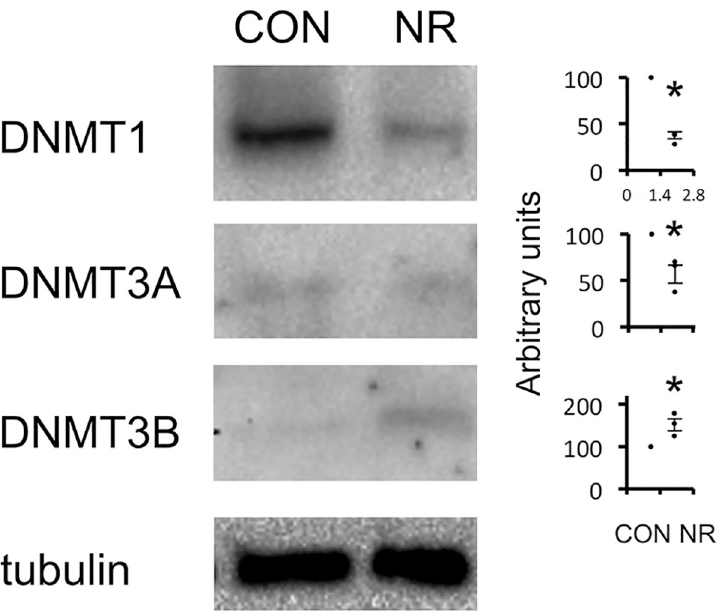
Fig 4. Expression of DNA methyltransferases in the kidney from embryonic day 15. (A) Representative immunoblot. (B) Quantitative analysis. n = 3 litters. n = 10–15 animals per litter. Statistical analysis was performed with unpaired t test. DNMT, DNA methyltransferase; CON, controls; NR, offspring of nutrient-restricted mothers. Bars represent ± SE. � , P < 0.05 vs CON.